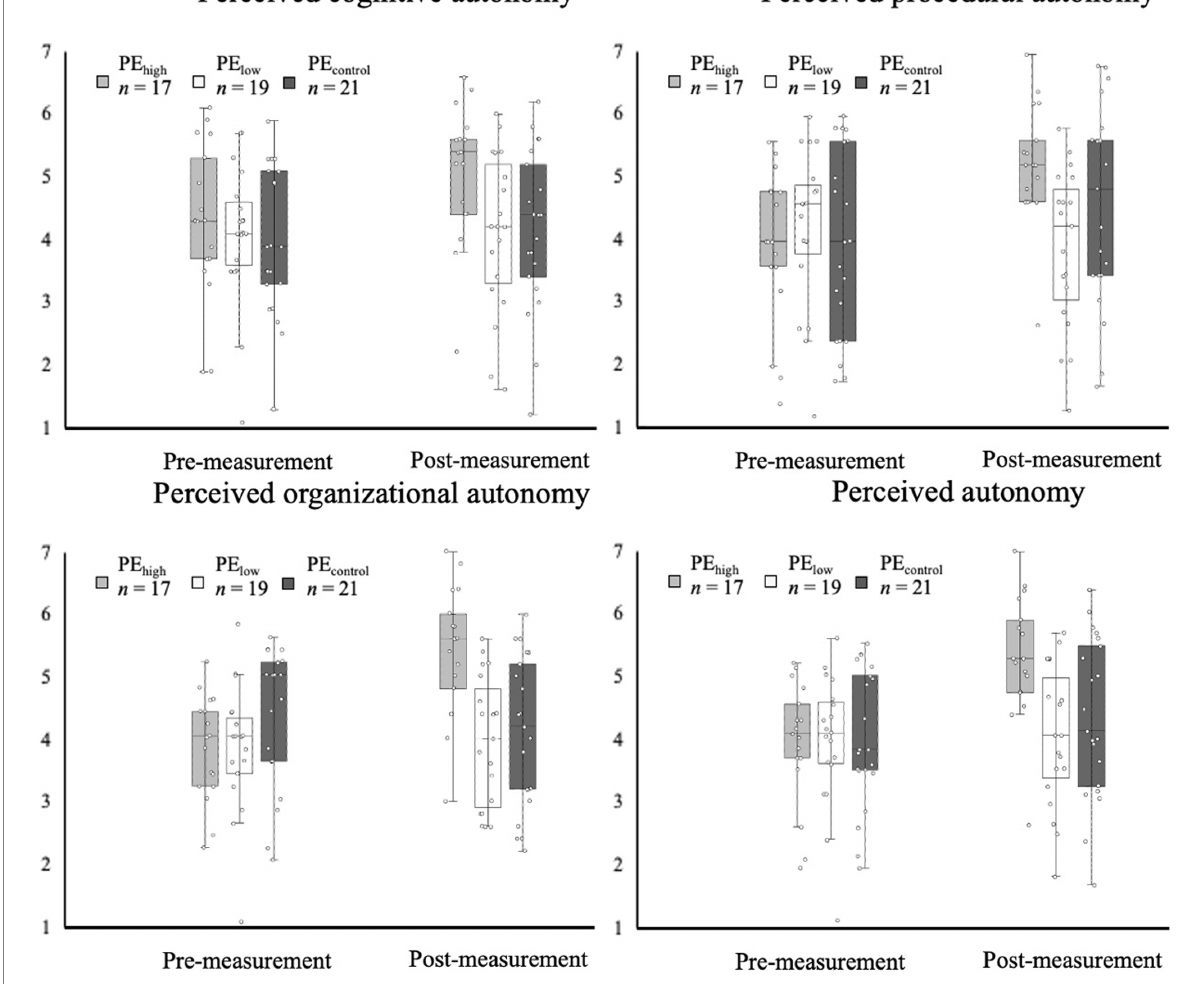
FIGURE 2 Boxplot charts show distribution of data points at pre- and post-measurement for perceived autonomy support—cognitive, procedural, organizational autonomy support, and total score of perceived autonomy support—in high (PE high ), low autonomy-supportive (PE low ) and controlling PE classes (PE control ). Single data points